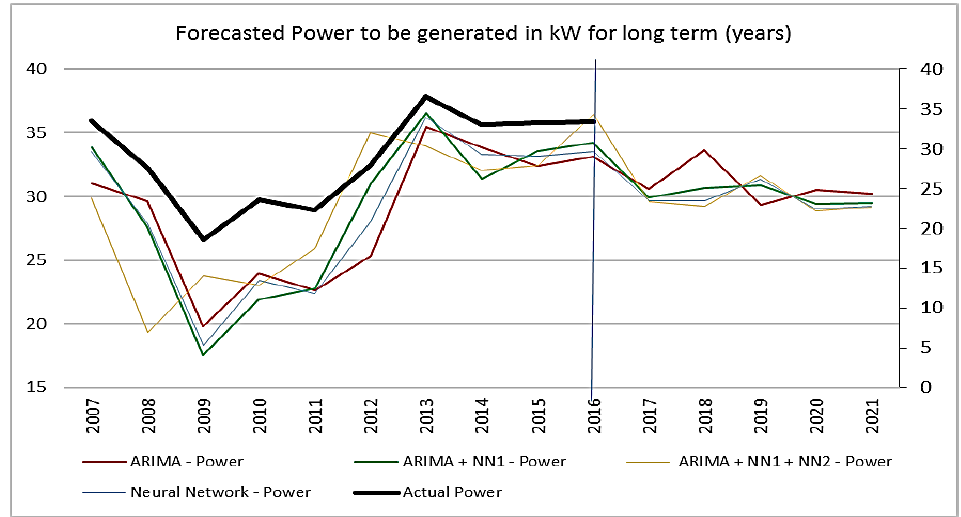
Figure 19. Predicted generated power in kW for long-term forecasting (years). Source: Authors.